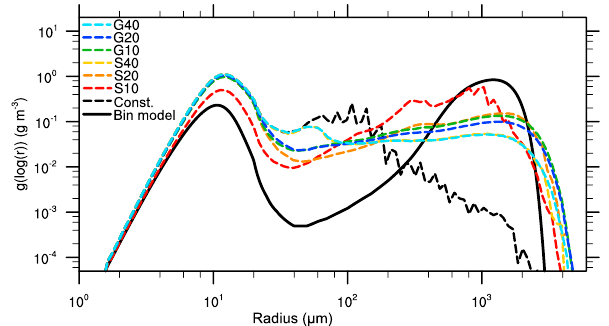
Figure 5. Mass density distribution for the single-box approach af- ter 3600s. The black solid line denotes the solution of Wang et al. (2007), the black dashed curve the reference case (without split- ting). The colored dashed curves show solution for splitting simula- tion with different configurations.